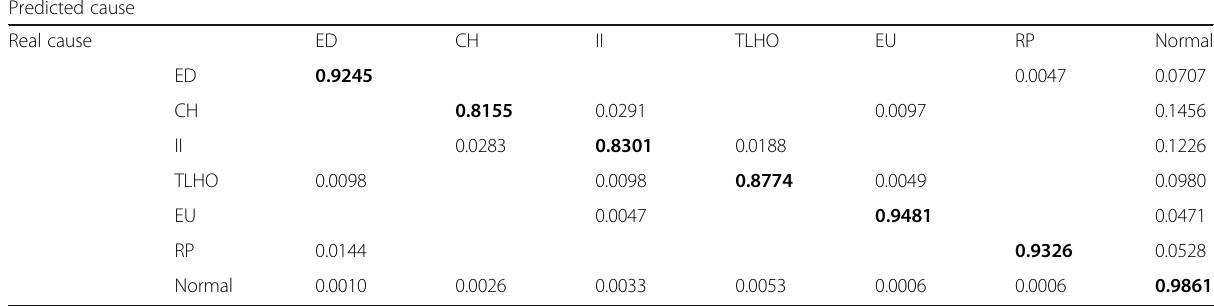
Table 6 Normalized confusion matrix of GA-AdaBoostLSVM method with optimal parameter values Predicted cause Real cause